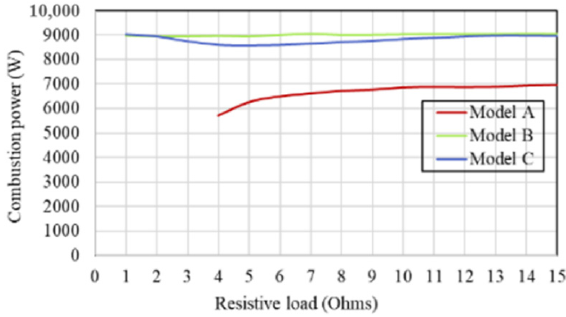
Figure 19. Combustion power versus resistive load.